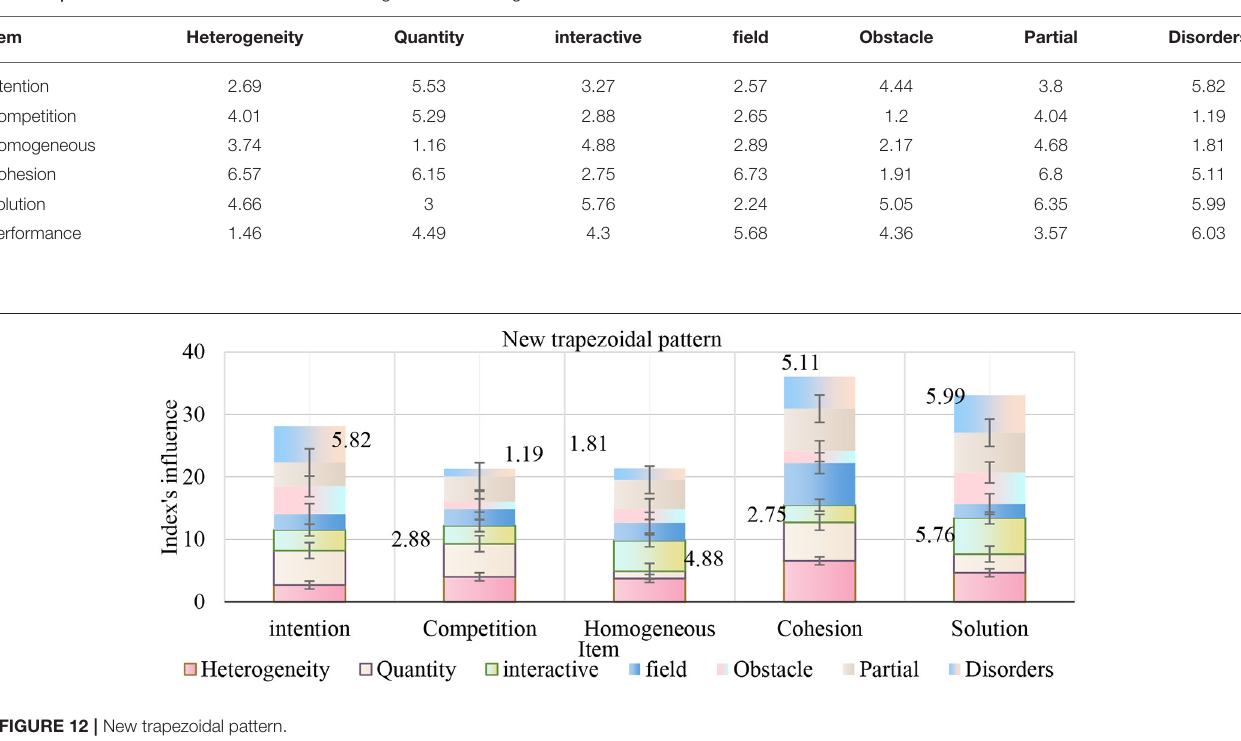
TABLE 9 | The number of teams and members in English team learning.